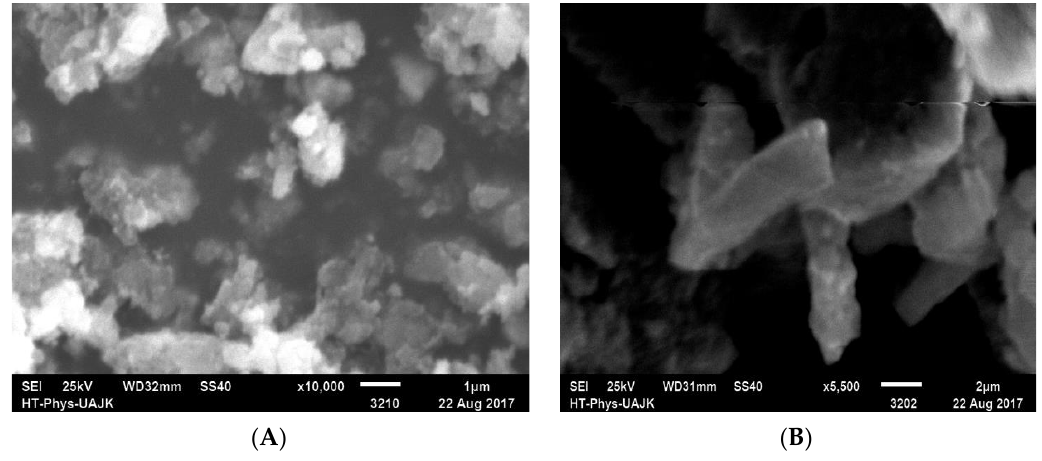
Figure 4. SEM images of AgNPs synthesized by Aesculus indica ’s bark extract. ( A ) High-resolution image. ( B ) Medium-resolution